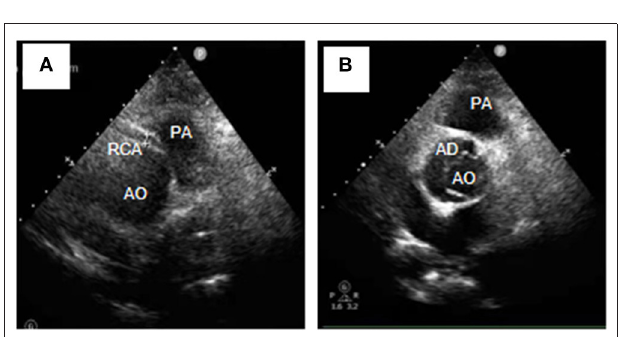
FIGURE 3 | Total aorta plus coronary computed tomography angiogram showed the Stanford type A aortic dissection (A–C) , the RCA originated from the LCS (C,D) and coursed between the aorta and the pulmonary artery (D) . RCA, right coronary artery; LCA, left coronary artery; AD, aortic dissection; AO, aortic; PA, pulmonary